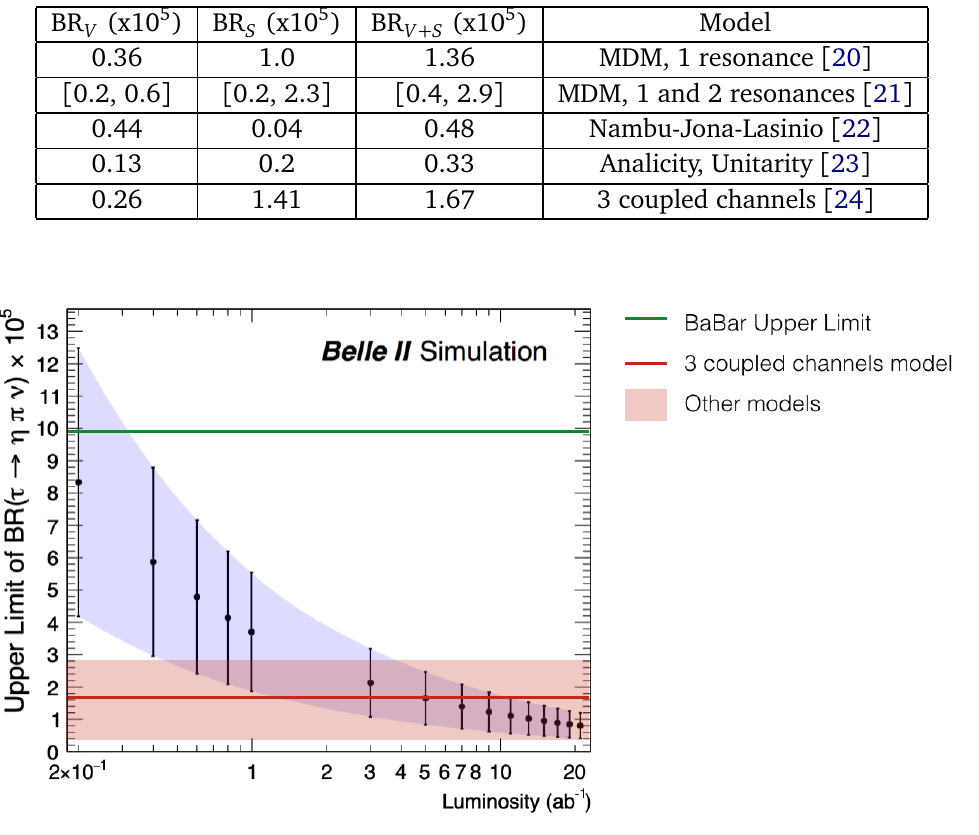
Figure 7: Prospects for 90% C.L. upper limits to be imposed by Belle II for the branching fraction of the decay τ → ηπν , as function of the integrated luminos- ity recorded. Red line represents the prediction for branching ratio of the 3 coupled channels model [ 24 ] and red band contains other SM predictions described in table